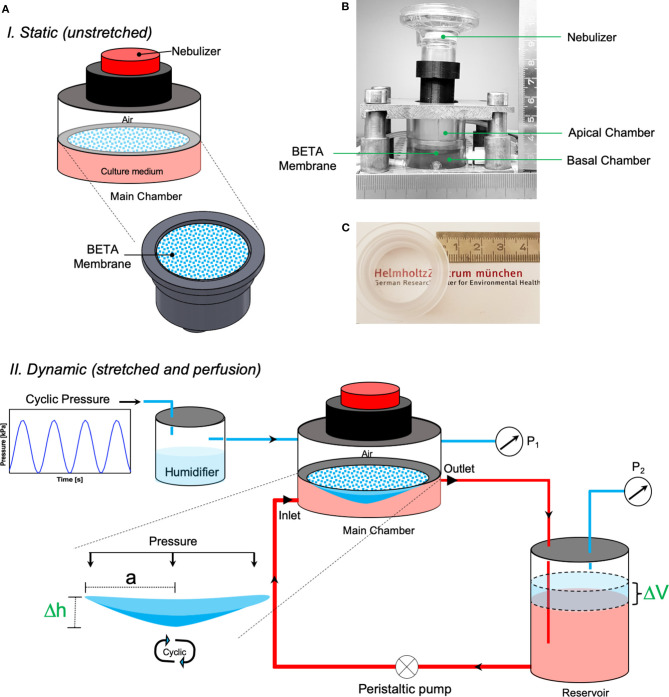
The CIVIC system used in this study. (A) Schematic depiction of the CIVIC system under (top) static (unstretched) and (bottom) dynamic (stretched and perfusion) conditions with the pressure-based strain/elasticity monitoring system. A thin, permeable, and stretchable membrane (BETA) placed in the (PDMS-free) main chamber of the bioreactor separates the apical (air) and basal (medium) compartments. Lung cells are grown on the membrane at ALI and perfused with culture medium by circulating the medium in the basal compartment with a perfusion pump to mimic blood flow. Cyclic mechanical stretch is applied to the cells on the membrane by applying cyclic (positive) pressure (P1) to the apical compartment. The cell/membrane stretch profile can be monitored via a pressure sensor in the air volume of the medium reservoir (P2), which is connected to the main chamber. The apical compartment of the bioreactor can be connected to a nebulizer to deliver aerosolized particles/drugs to the cells. (B) Snapshot of the main chamber of the CIVIC bioreactor system. (C) Photograph of the BETA membrane in the PC holder of the CIVIC system, which is transparent, thus favorable for direct cell imaging applications.